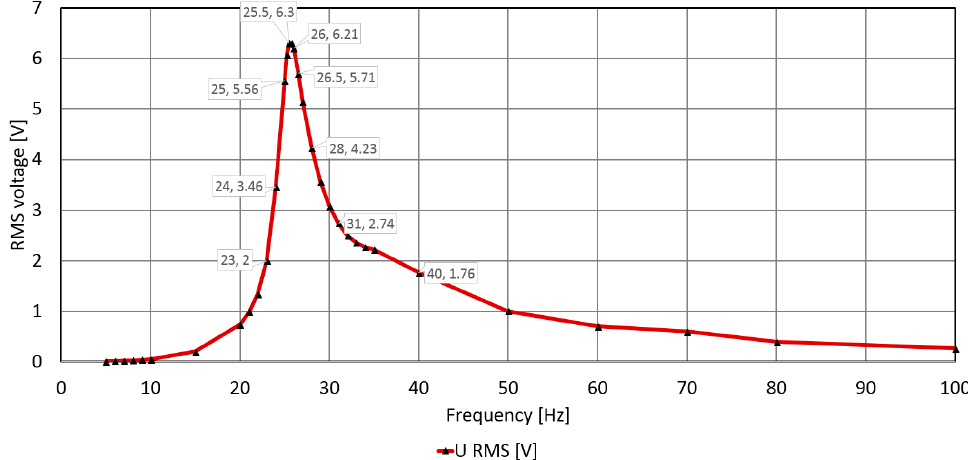
Figure 4. Frequency response of the Mide PPA-1014 piezoelectric cantilever adjusted to 26 Hz. The measurement was taken on a vibration shaker with 250 mg acceleration excitation and with a resistive load on the piezoelectric output of 127.5 k Ω